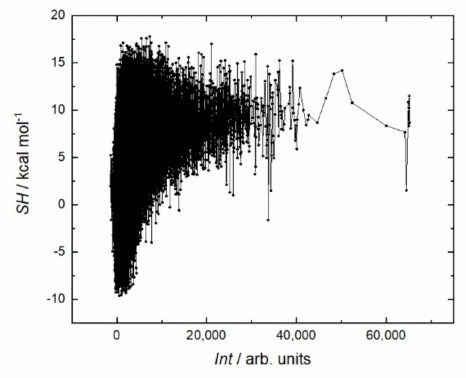
Figure 6. Fluorescent intensity Int of RTX interaction with the resemblance-ranking peptide library versus the sum hydrophobicity SH of the corresponding peptides [28]. Wimley–White whole-residue hydrophobicity scales were used for calculations.